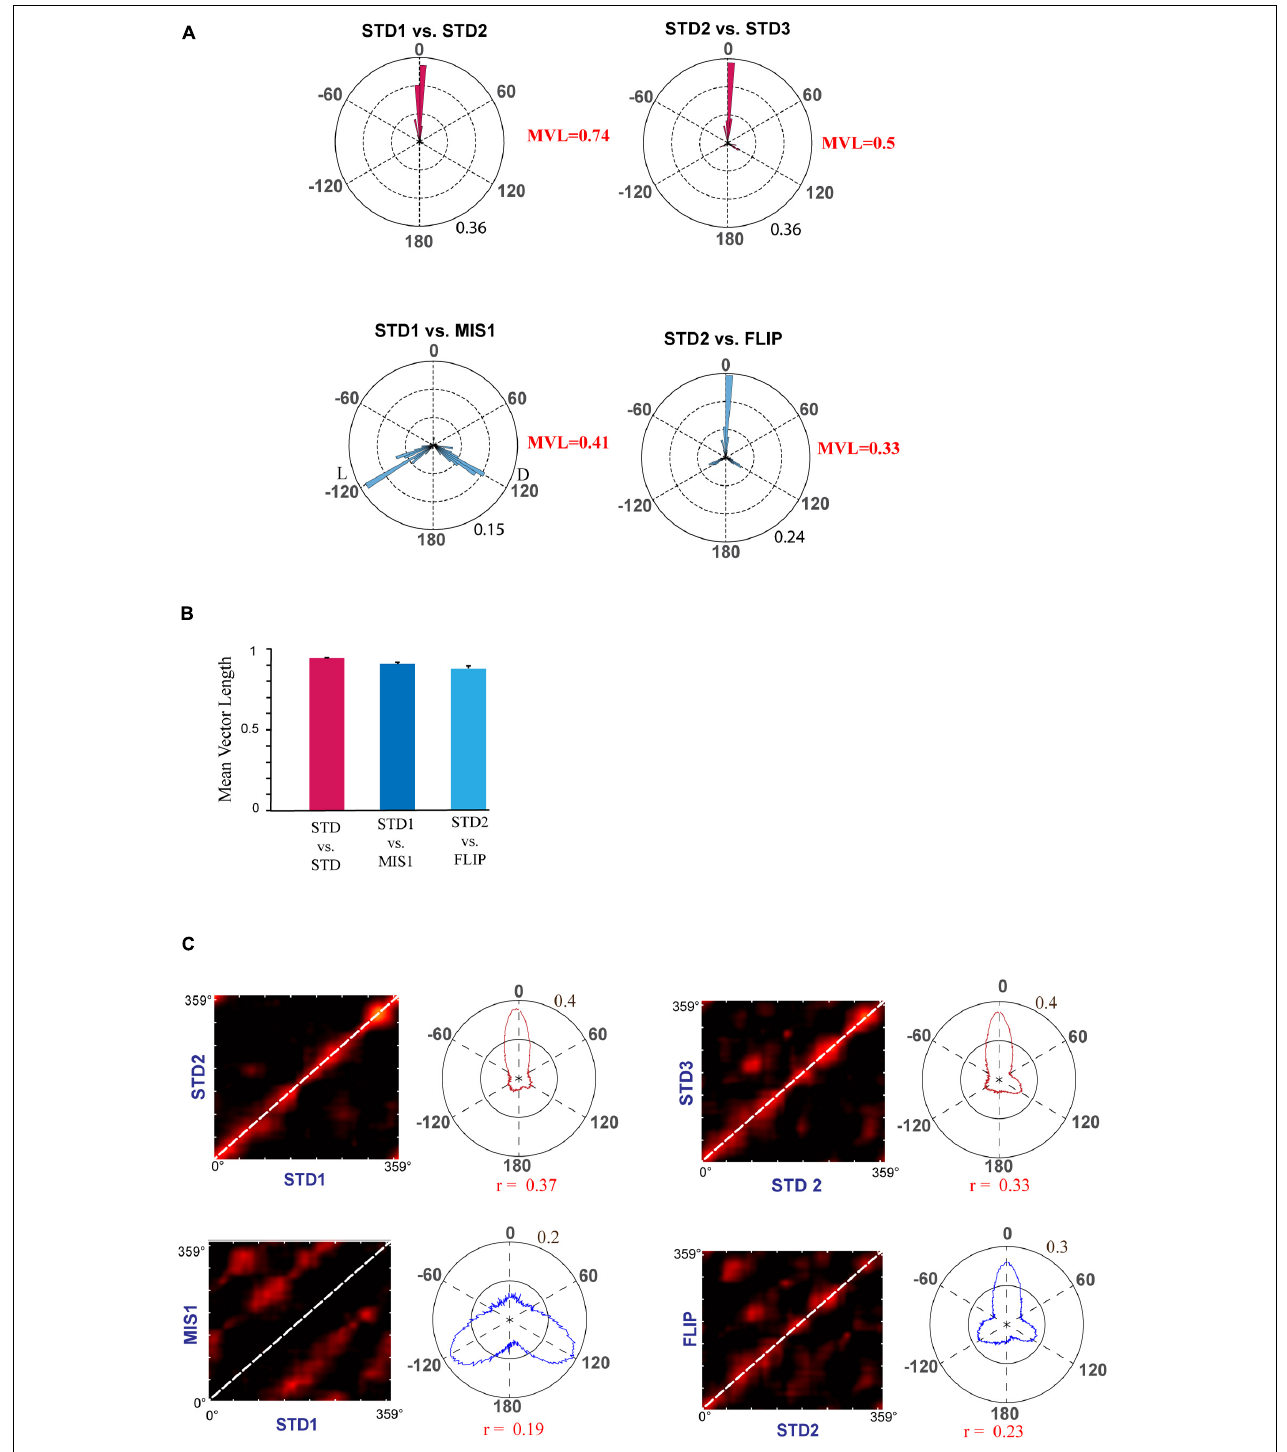
FIGURE 6 | Representation of rotational correlation of place field population in the RwdMag experimental paradigm. (A) Circular histogram of rotational correlation of place fields in standard and mismatch/FLIP comparison. Mean vector length (MVL) of each comparison is shown near the corresponding plots. L and D indicate the rotation of local and distal cues. (B) Mean vector length of ensembles comparing STD and mismatch/FLIP comparisons. An error bar indicates the standard error of the mean. (C) Population correlation matrices of standard and mismatch/FLIP comparisons with the polar plot. The diagonal is marked with white-dotted lines. Transformation of the 2D correlation matrix to a 1D polar plot is presented alongside the correlation matrix. Maximum correlation value (r) of the polar plot is shown below the polar plot.